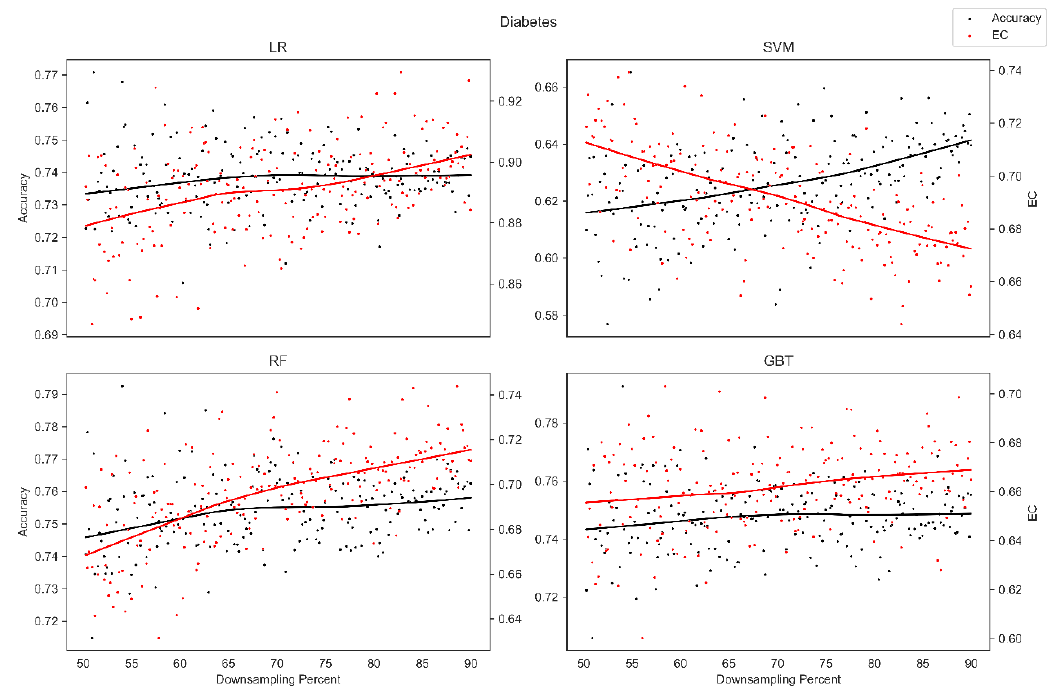
Figure 3. Average error consistency and overall accuracy vs. varying sample size percentages (down-sampled) from the Diabetes dataset. Trend lines were established with locally weighted regression and smoothing [25].